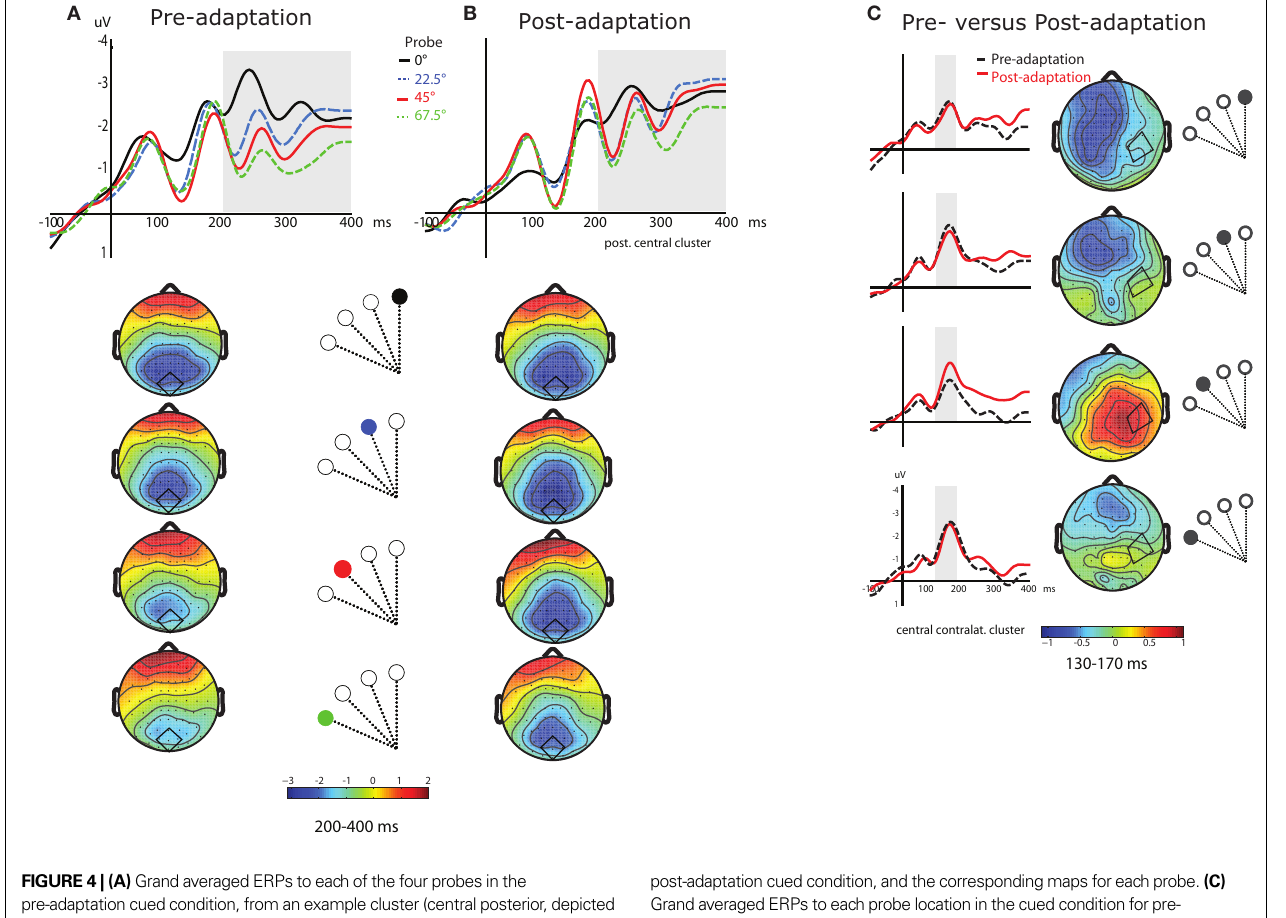
FIGURE 4 | (A) Grand averaged ERPs to each of the four probes in the pre-adaptation cued condition, from an example cluster (central posterior, depicted in each map) (probe located at 0 ° , black; 22.5 ° , blue dashed; 45 ° , red; 67.5 ° , green dashed). Topological maps below show the distribution of the effect for each probe in the second time interval (200–400 ms), corresponding to the gray shaded area in the ERP traces. (B) ERPs from an example cluster (central posterior) in the